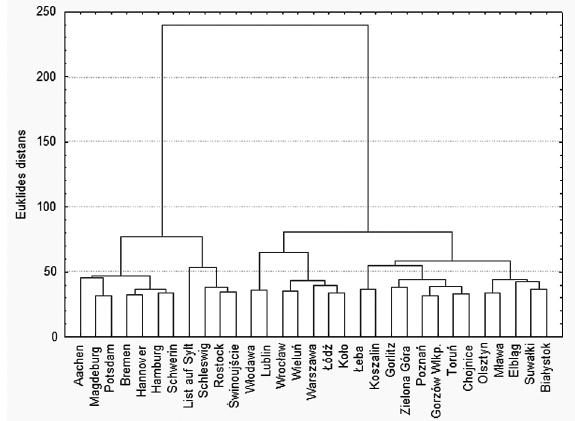
Fig. 3. The grouping of meteorological stations.